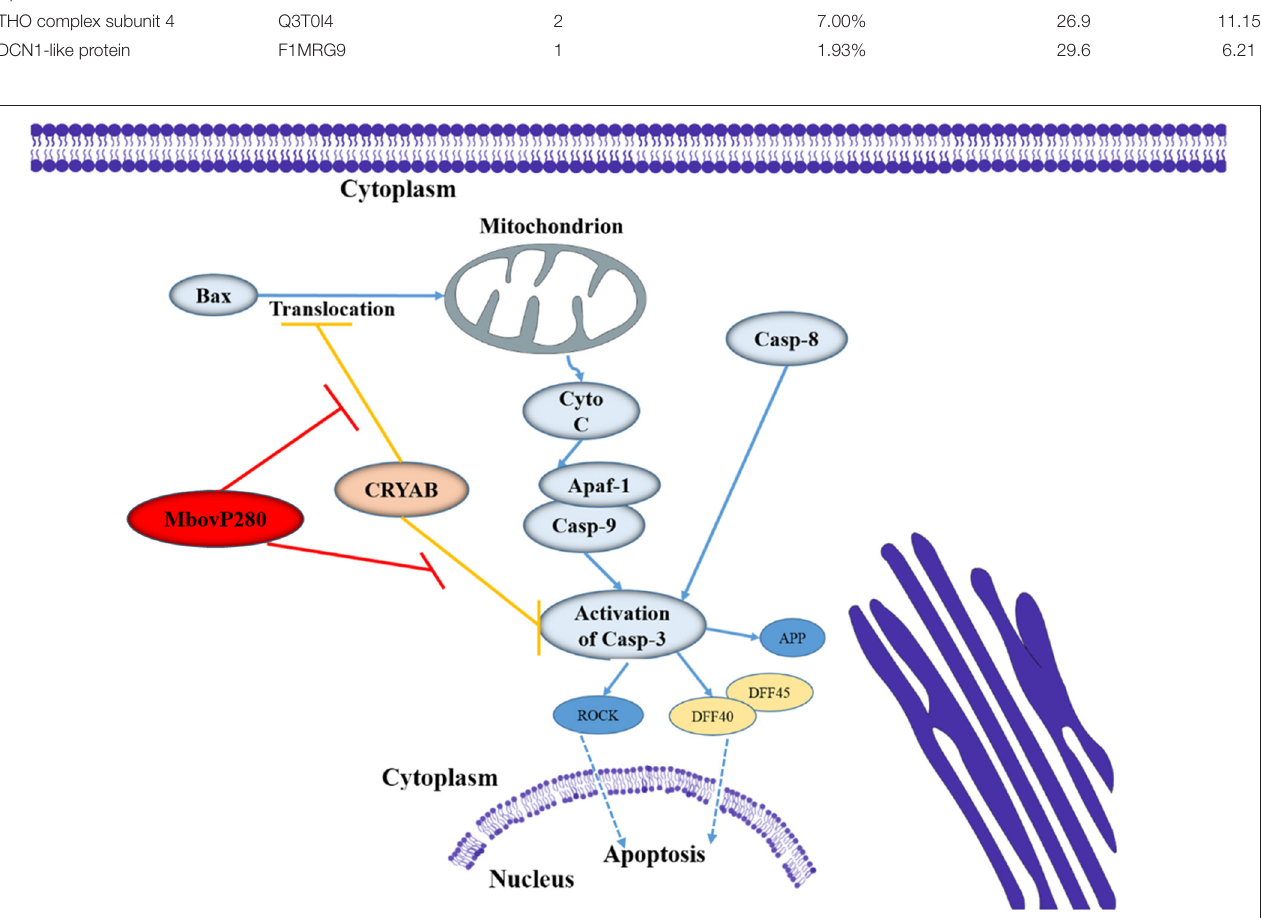
FIGURE 5 | Diagram of the possible signaling pathway of MbovP280-induced apoptosis in BoMac. MbovP280 binds to CRYAB and induces apoptosis of BoMac cells through CRYAB.